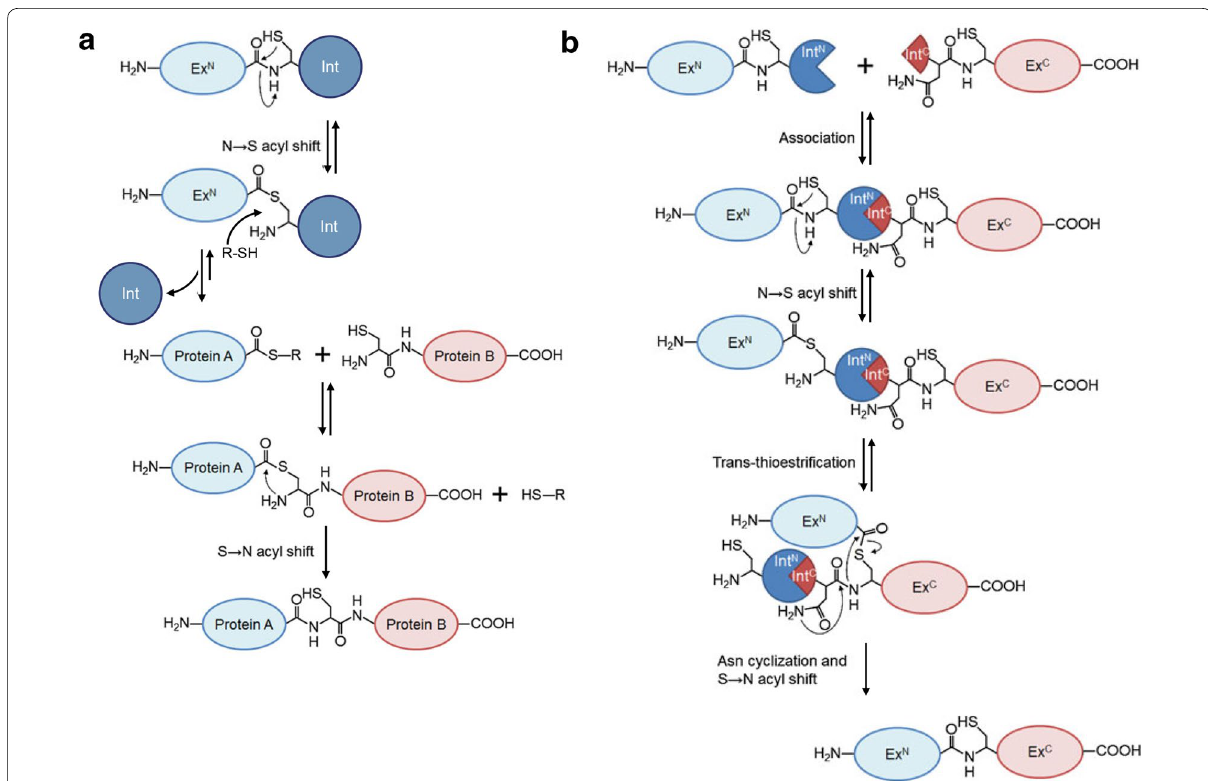
Fig. 22 Intein-based chemical conjugation. a Expressed protein ligation (EPL) is a semisynthetic version of NCL in which synthetic and recombi- nant polypeptides are chemically ligated together. Proteins (A) expressed as intein fusions can be cleaved from the intein with a variety of thiols to give the corresponding α-thioester derivative. Proteins (B) containing N-terminal Cys can be made recombinantly by masking the Cys with a pro- tease tag that can be later removed. b Protein trans-splicing (PTS) post-translationally links two protein fragments. An intein domain is split into two fragments, Int N and Int C , which are fused to the flanking exteins, Ex N and Ex C . Ex N –Int N and Int C –Ex C associate and fold to form a functional intein. This functional intein can restore protein splicing activity to excise itself, and to conjugate ExN and ExC with a peptide bond (Figures adapted with permission from: Ref. [106]. Copyright (2012)